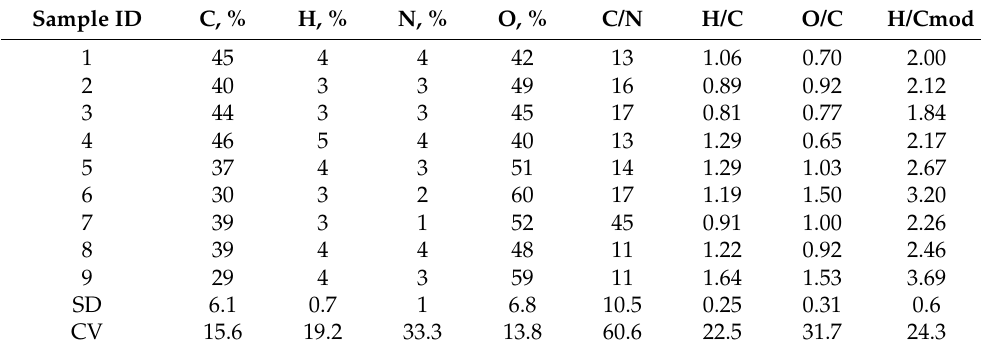
Table 3. The elemental composition of studied HAs. Sample ID corresponds to Table 1.